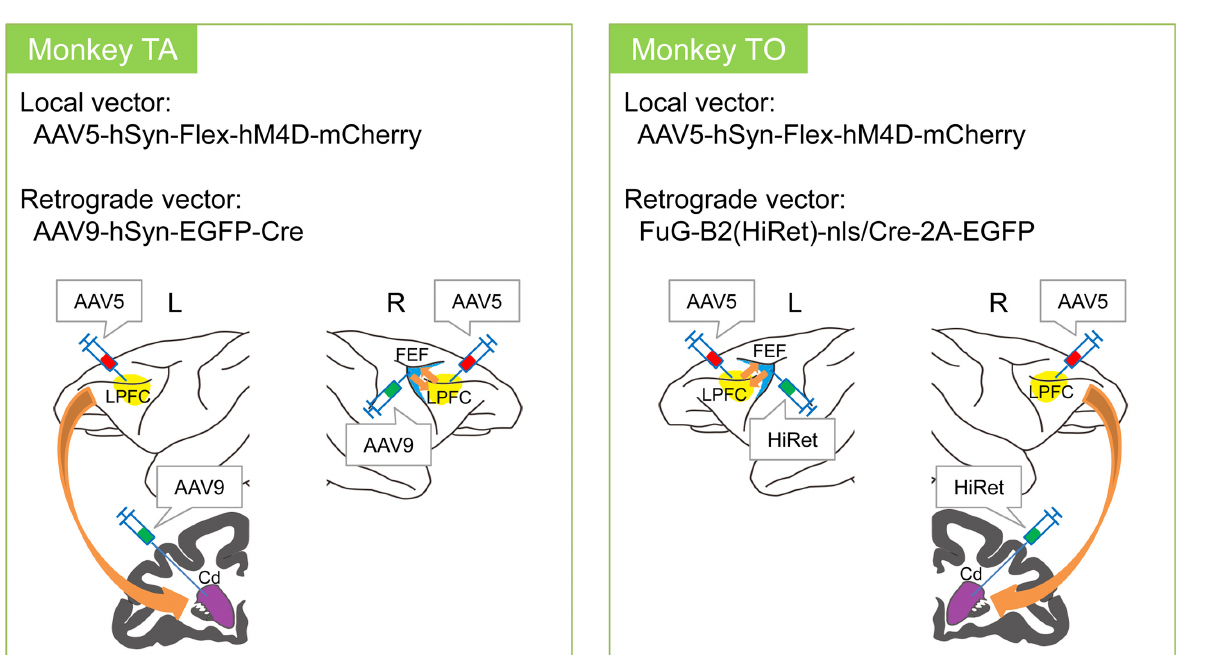
Fig 2. Target pathway and injected local and retrograde virus vectors. AAV5 was injected into the bilateral LPFC of both monkeys. AAV9 was injected into the left Cd and the right FEF of Monkey TA. HiRet was injected into the right Cd and the left FEF of Monkey